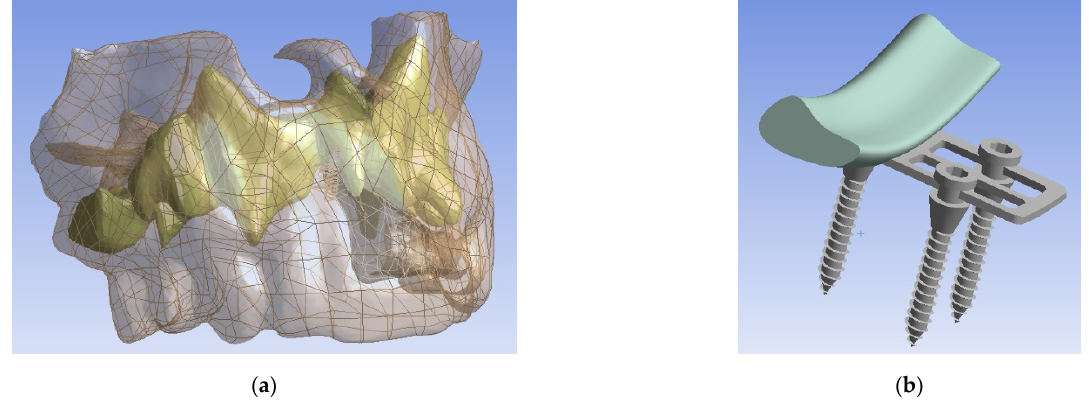
Figure 1. 3D solid geometrical models: ( a ) two types of jawbone tissue, transparent—cortical bone, yellow—trabecular bone; ( b ) implant of the first configuration (Model 1).